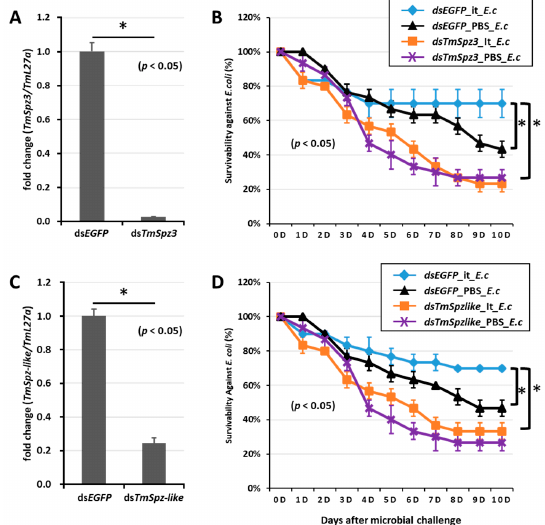
Figure 8. Survivability of T. molitor larvae against E. coli after TmSpz-3 or - like gene silencing and iturin A injection. The TmSpz-3 or - like gene were silenced, and the silencing efficiency was measured by qRT-PCR at 3 d post-injection ( A , C ). Iturin A (It) was then injected into the TmSpz-3 ( B ) and - like ( D ) gene-silenced larvae. After 24 h of iturin A injection, E. coli (E.c) was injected into the gene-silenced larvae. ds EGFP and 1XPBS were injected as control for gene and iturin A- or microbe-injected groups, respectively. The data represent the mean of three biological replicate experiments. *significant differences between ds TmSpz-3, - like, and ds EGFP -treated and PBS-injected larval groups ( p < 0.05). Int. J. Mol. Sci. 2020 , 21 , x FOR PEER REVIEW